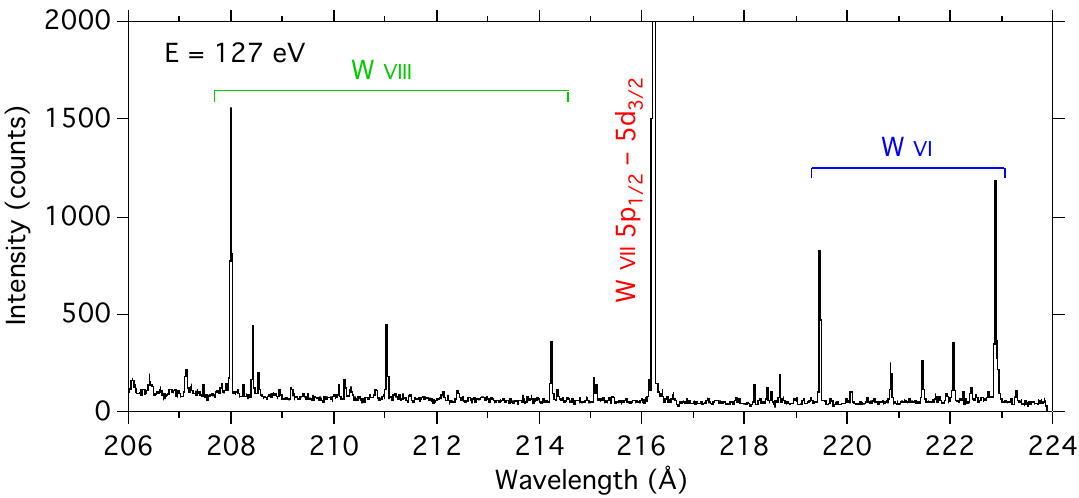
Figure 3. Measured spectra of tungsten at EBIT-I at a nominal beam energy of E = 127 eV.